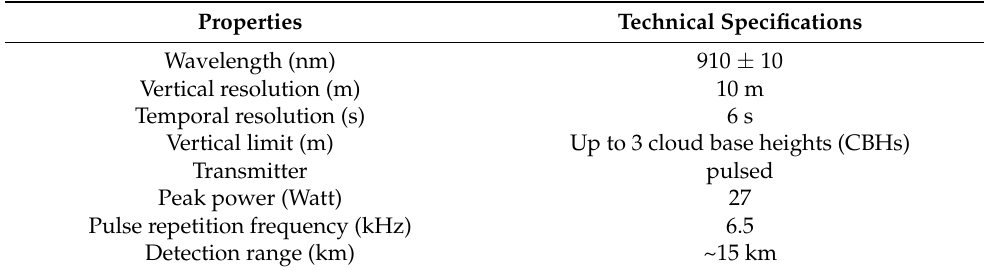
Table 1. The CL51 ceilometer